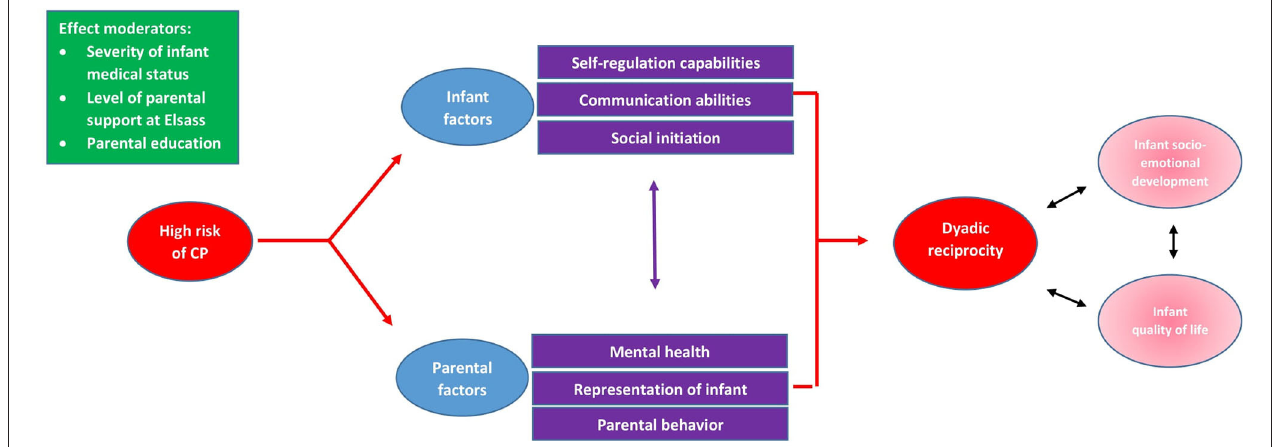
FIGURE 1 | Study Model.